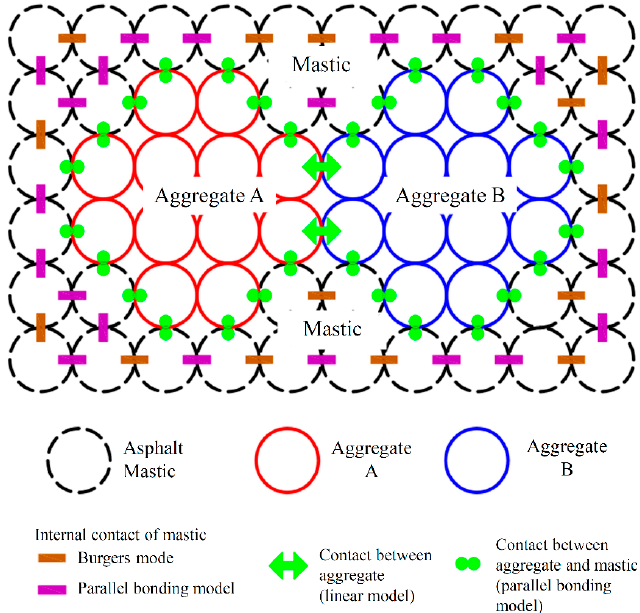
Figure 11. The schematic diagram of the contact model in the asphalt